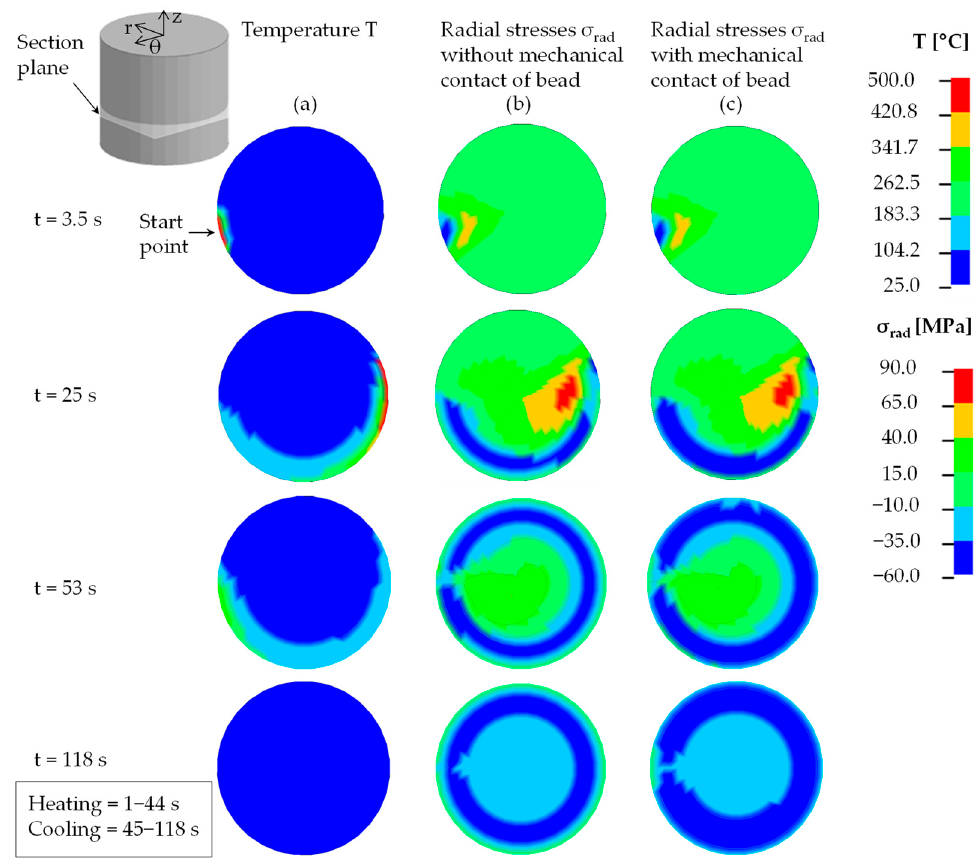
Figure 14. Temperature ( a ) and radial stress development on the tool (along a section plane) without mechanical contact of the bead ( b ) and with mechanical contact of the bead ( c ) at different times. The mean surface temperature and the equivalent stress for an element (having a size of 10.45 mm × 0.5 mm) are shown in Figure 15. As the heat source moves away from the reference element, the liquid metal solidifies, causing thermal shrinkage, visible in the sloping curve. After cooling to around 70 °C, the stress curve reveals a constant value of approximately 160 MPa on the tool surface.